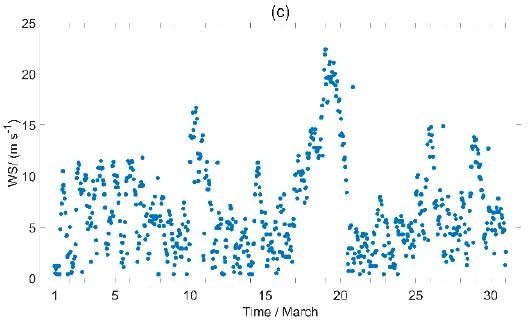
Figure 7. Diurnal variations of WS at heights of ( a ) 10 m, ( b ) 30 m and ( c ) 60 m of the anemometer tower in March 2014 (unit: m · s − 1 ).